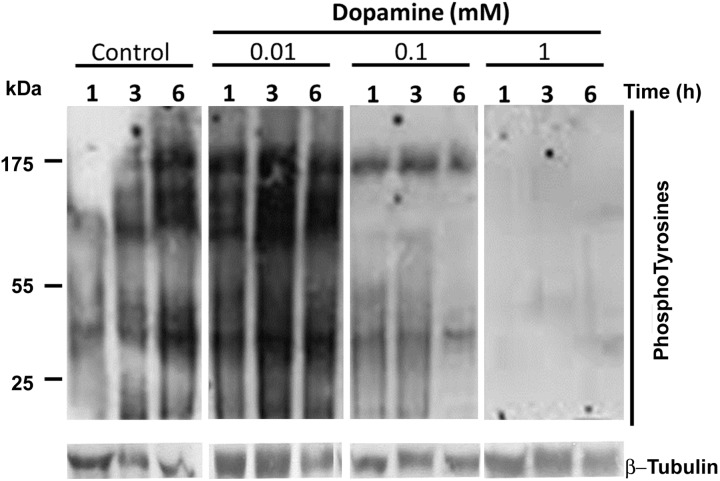
High levels of dopamine reduce tyrosine phosphorylation during capacitation in equine sperm.Effects of dopamine on tyrosine phosphorylation after different times of incubation and dopamine concentrations (0, 0.01, 0.1 and 1 mM) were assessed by Western blot using PY20 anti-phophotyrosine antibody. The image is representative of two independent experiments.